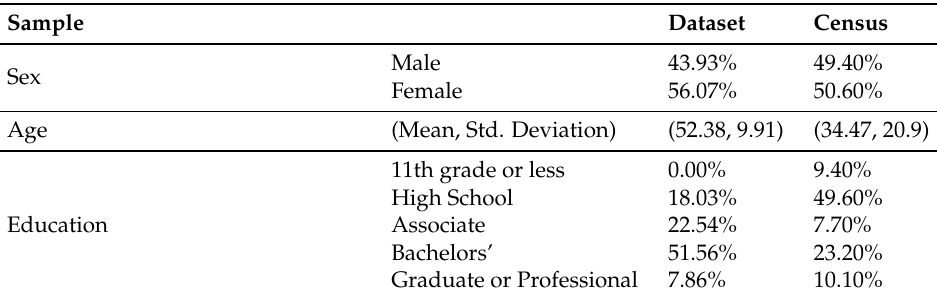
Table 1. Socio-demographic attributes of the